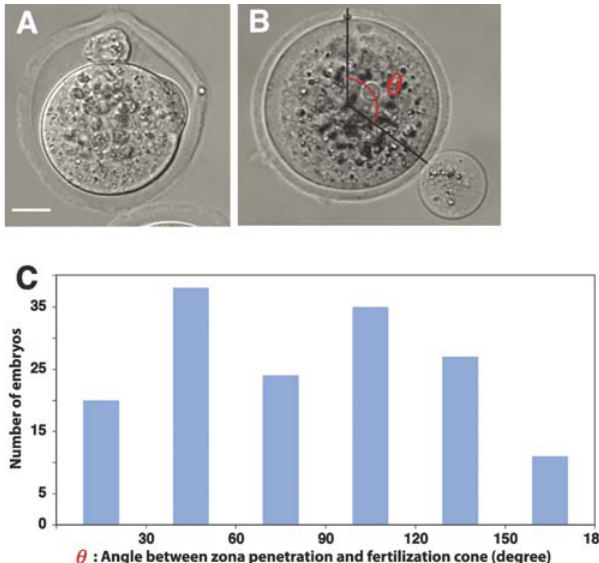
Figure 2. Sperm Fertilizes at a Point Far Distant from Its Site of ZP Penetration (A) Zygote with an oil drop marking the position of the fertilization cone. (B) The embryo after hypotonic treatment. The cytoplasmic protrusion marks the site of ZP penetration by the sperm. Arc distance ( h ) between the point of ZP penetration and fertilization is measured. (C) Distribution of the arc distance between the sites of ZP penetration and fertilization.